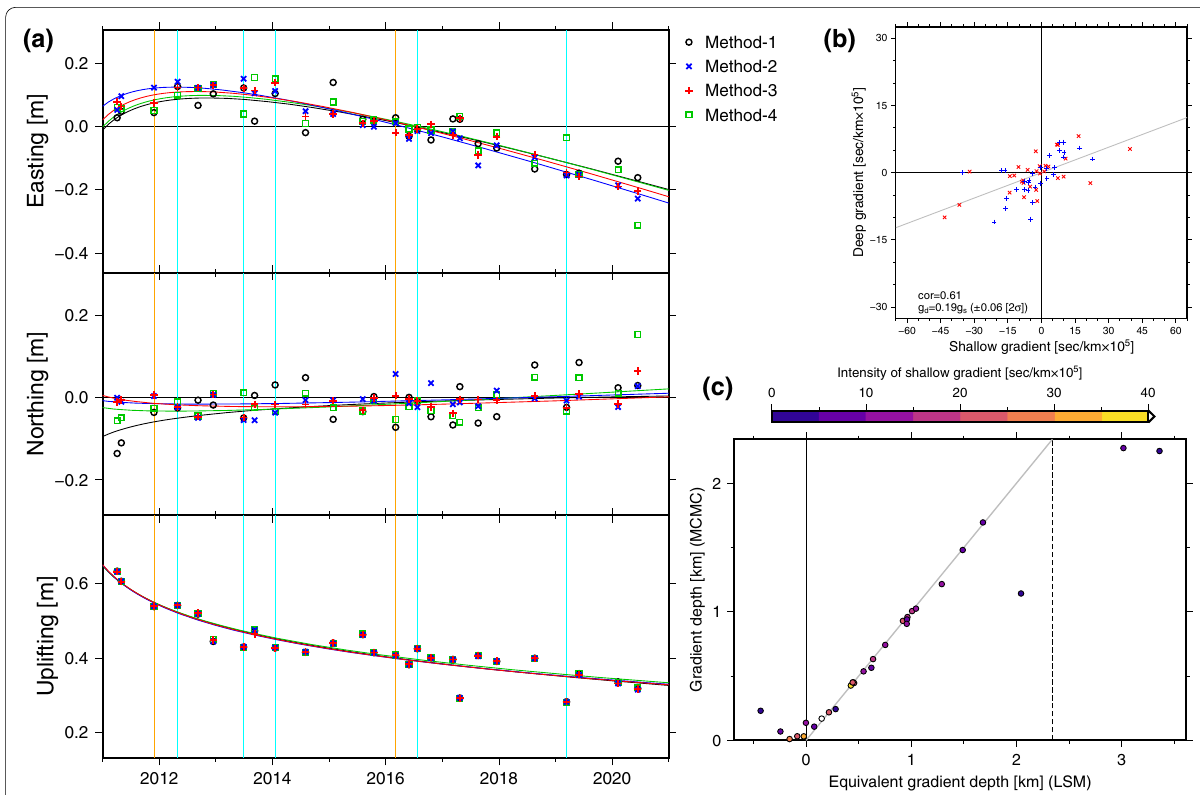
Fig. 5 Array positioning results at KAMN. a Time-series of the array positions. Open black circles, blue x-marks, red crosses, open green squares show the solutions estimated by Method-1, Method-2, Method-3, and Method-4, respectively. Cyan and orange vertical lines indicate the campaigns that the equivalent gradient depths are estimated to be lower than zero and larger than the seafloor depth, respectively. b Scatter diagram of the shallow gradients estimated by Method-3 and the deep gradients estimated by Method-2. Red and blue symbols represent EW and NS components, respectively. The solid line represents the linear regression line. The regression equation and the correlation coefficient are shown. c Scatter diagram of the equivalent gradient depths and the gradient depths estimated by Method-3. The colors of plots indicate the intensity of the shallow gradients estimated by Method-3. Solid and dashed vertical lines show the depths of zero and the